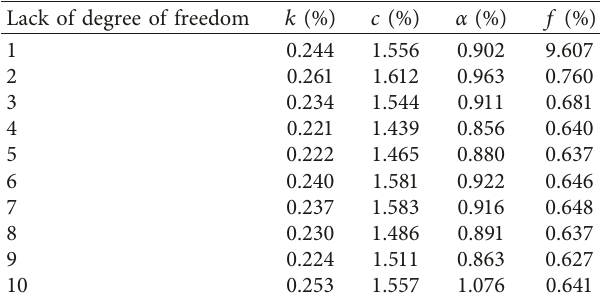
Table 4: Identified errors with different sets of nine measured points. Lack of degree of